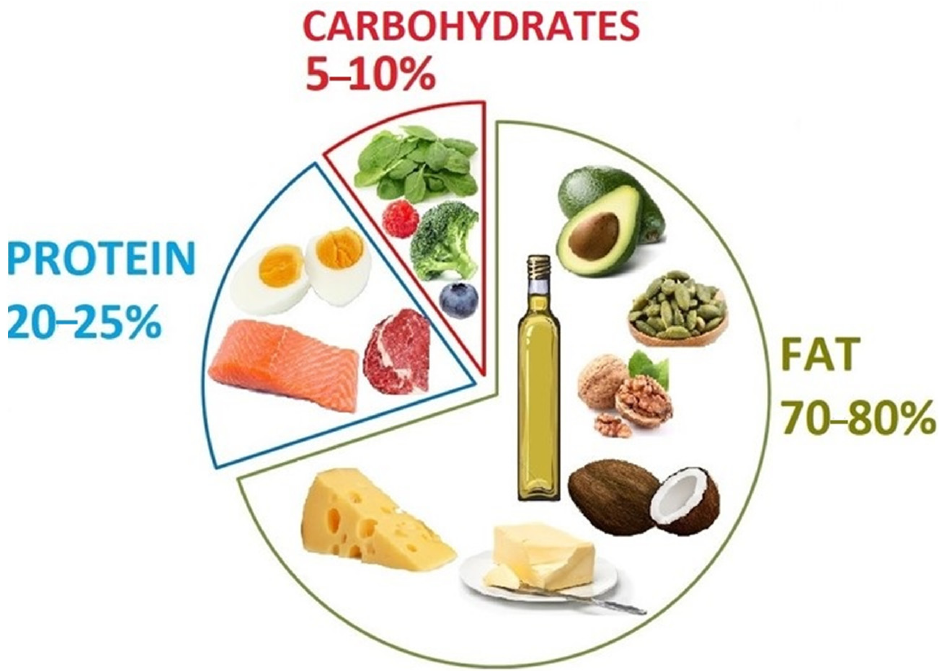
Figure 3. Distribution of macronutrients in a ketogenic diet.